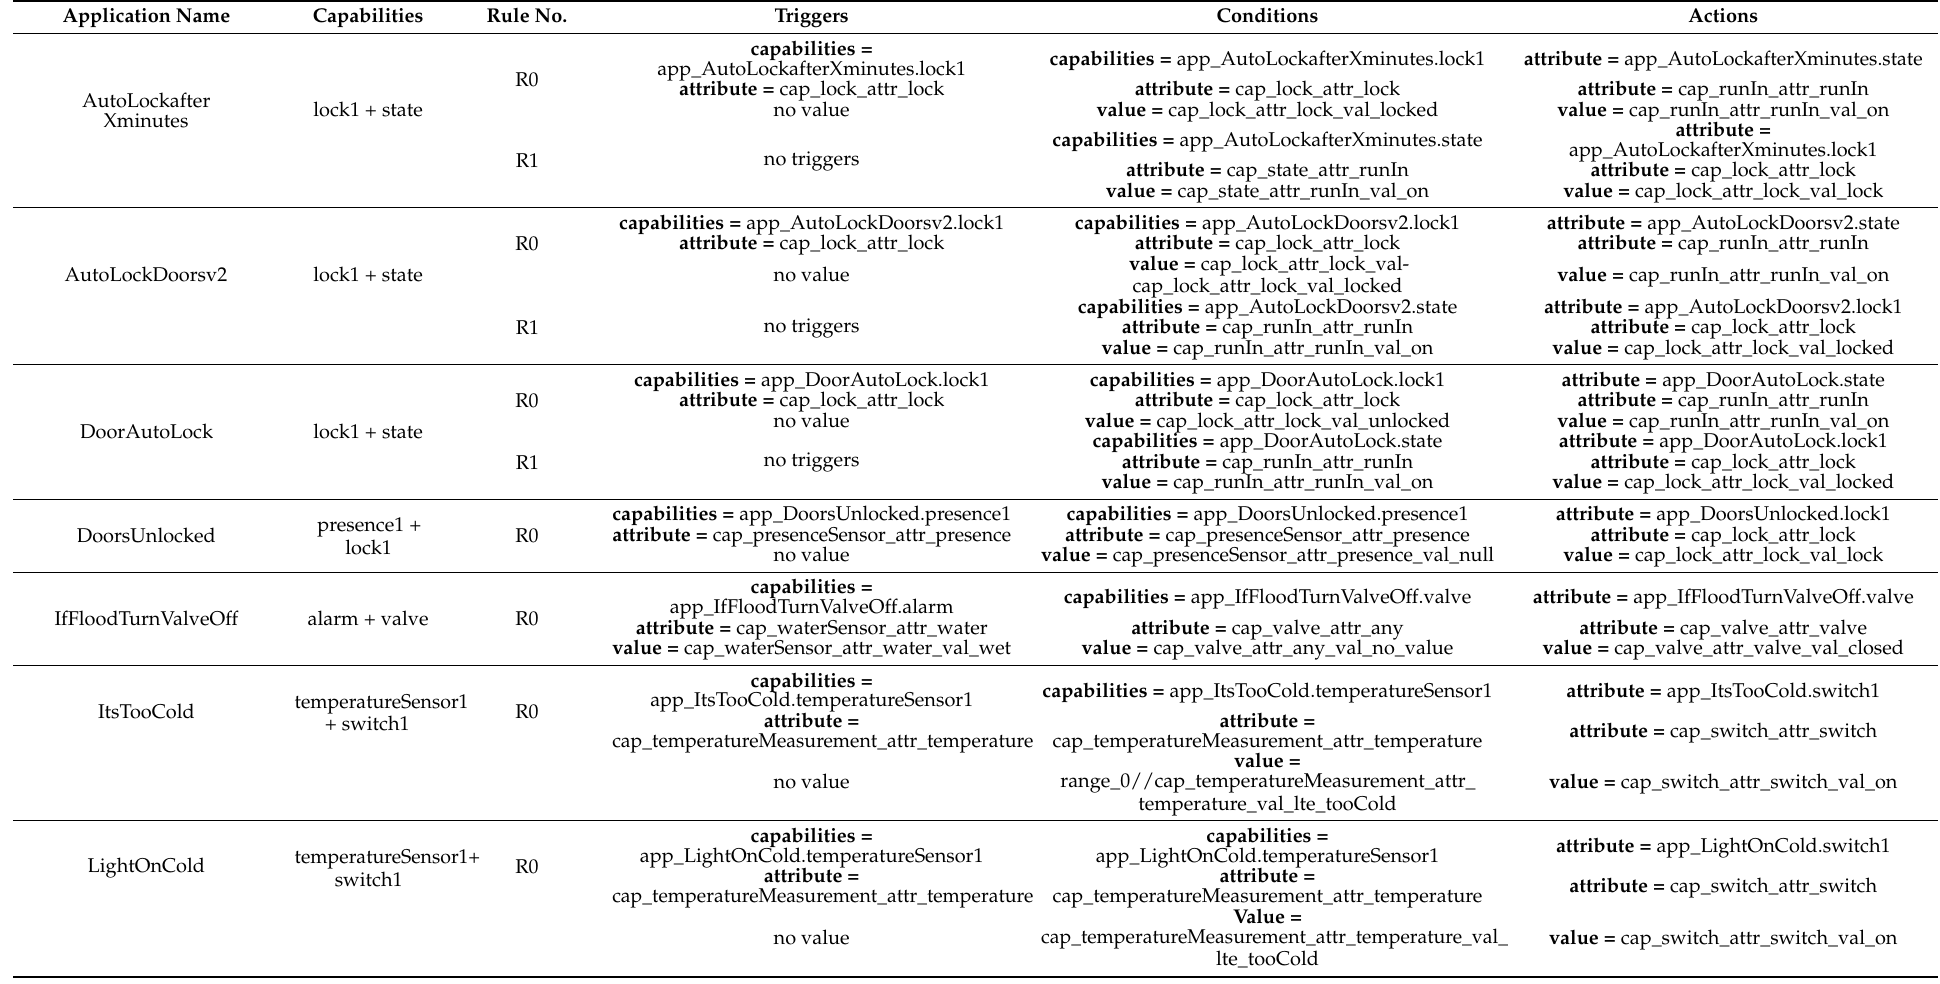
Table 3. Rules description of the IoT apps dataset in a smart